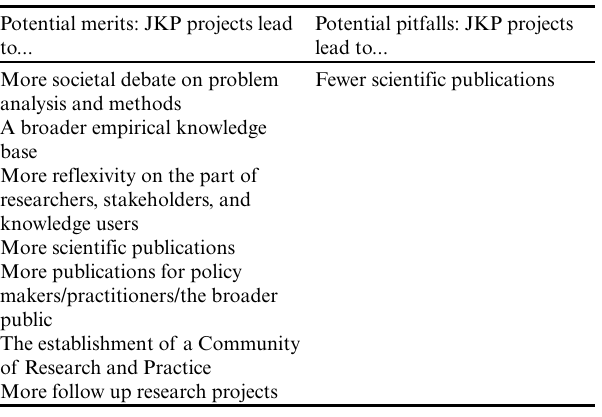
Table 9 . Empirically validated scientific merits and pitfalls of joint knowledge production (JKP)